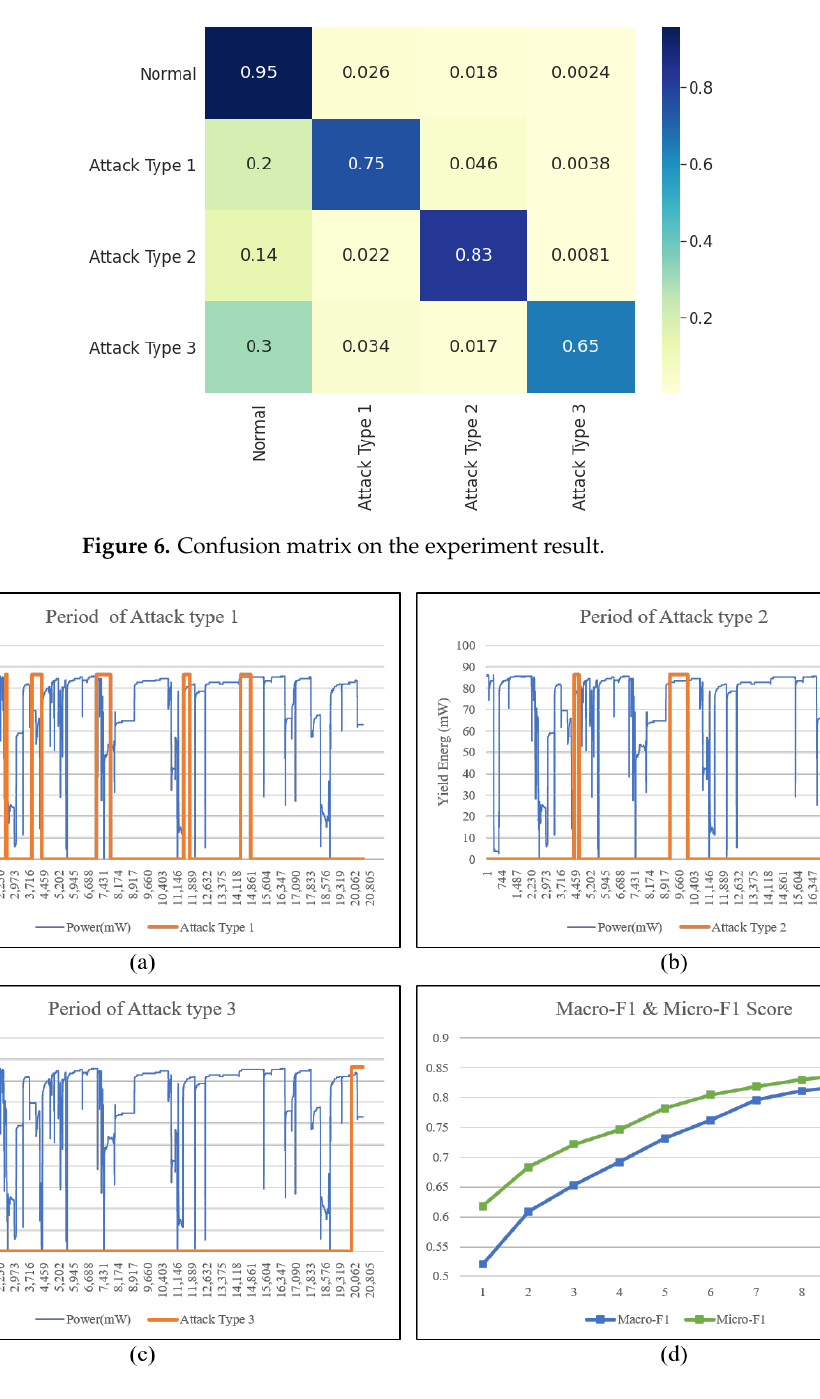
Figure 7. ( a – c ) Graph of the total energy production observed by the prosumer device and graph indicating the time when the attack was conducted (and the type). The blue line denotes the power production measured by the device, and the orange line indicates when the attack was conducted.( d ) Macro-F1 score and micro-F1 score value for the multi-class classification performance of the proposed